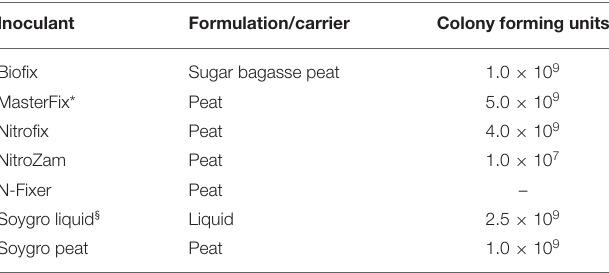
TABLE 3 | Minimum manufacturer’s specifications for colony-forming units per gram (CFU g − 1 ) or milliliter (CFU ml − 1 ) and carrier of the experimental inoculants.